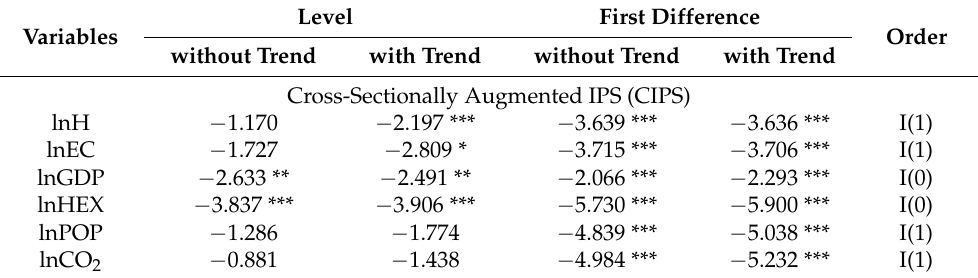
Table 5. Panel unit root test.